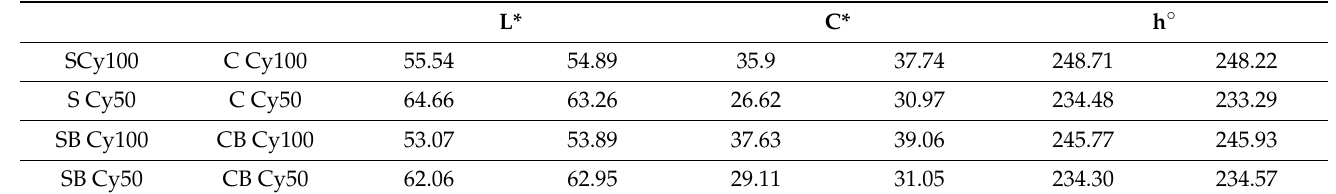
printed with cyan pigment.